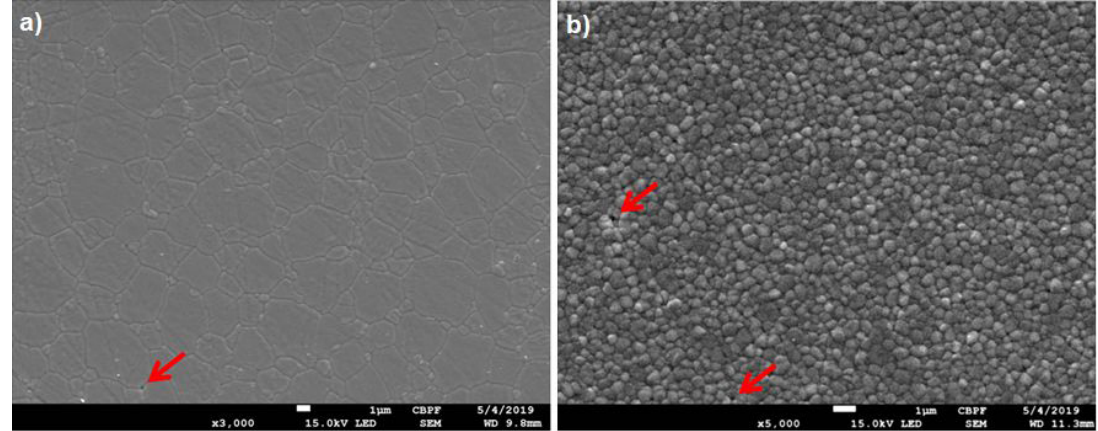
Figure 10. Examples of distribution and dimension of residual porosity in the analyzed specimens: a) G5 and b)